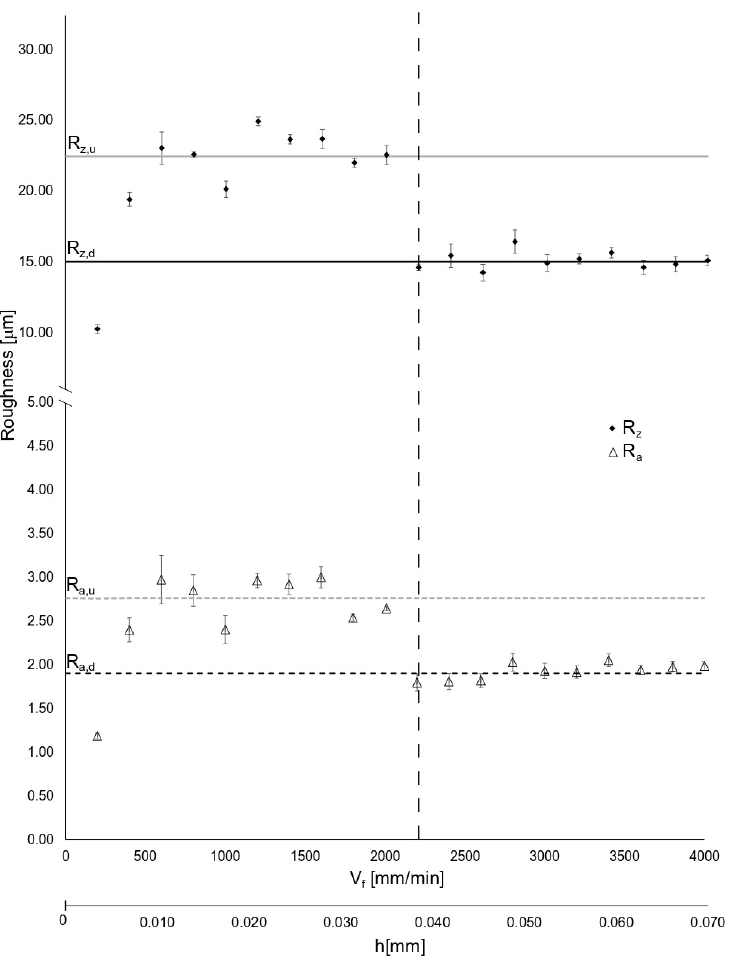
Figure 5. Roughness evolution in relation to the feed rate/chip thickness with the other parameters fixed (a spindle speed of 30,000 RPM, a radial depth of cut of 3 mm and an axial depth of cut of 0.7 mm). The evolutions are identical for both R a and R z with two distinct zones: a first zone where the roughness is relatively variable around R a,u with a maximum R a of 3 µ m and around R z,u with a maximum R z of 25 µ m. After a chip thickness of 0.037 mm, the roughness drops to stabilize at an R a value around 1.7 µ m (R a,d ) and an R z value around 15 µ m (R z,d